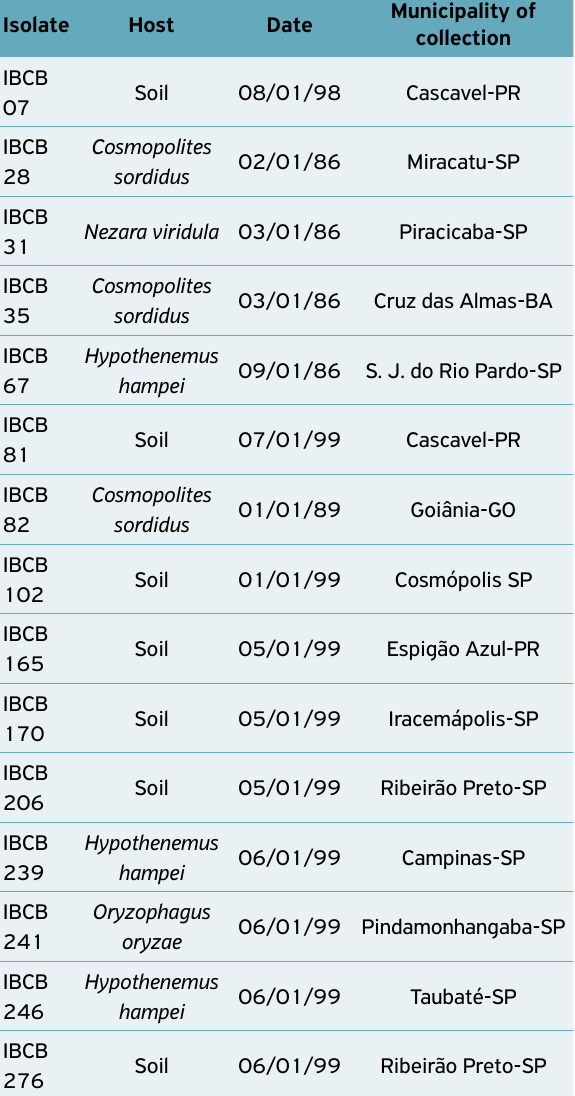
Table 1. Beauveria bassiana isolates used for selection against the fruit borer, Conotrachelus